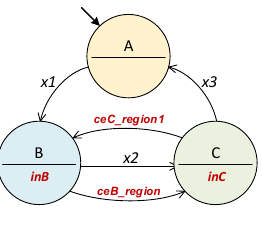
Figure 6. Master FSM ( Process ). Energies 2023 , 16 , x FOR PEER REVIEW